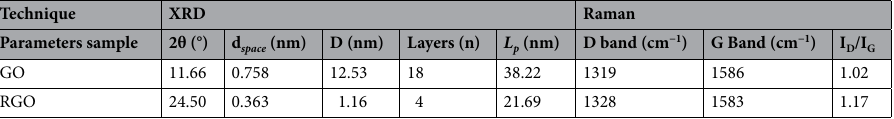
Table 1. Experimental parameters derived from XRD and Raman spectroscopy analysis.